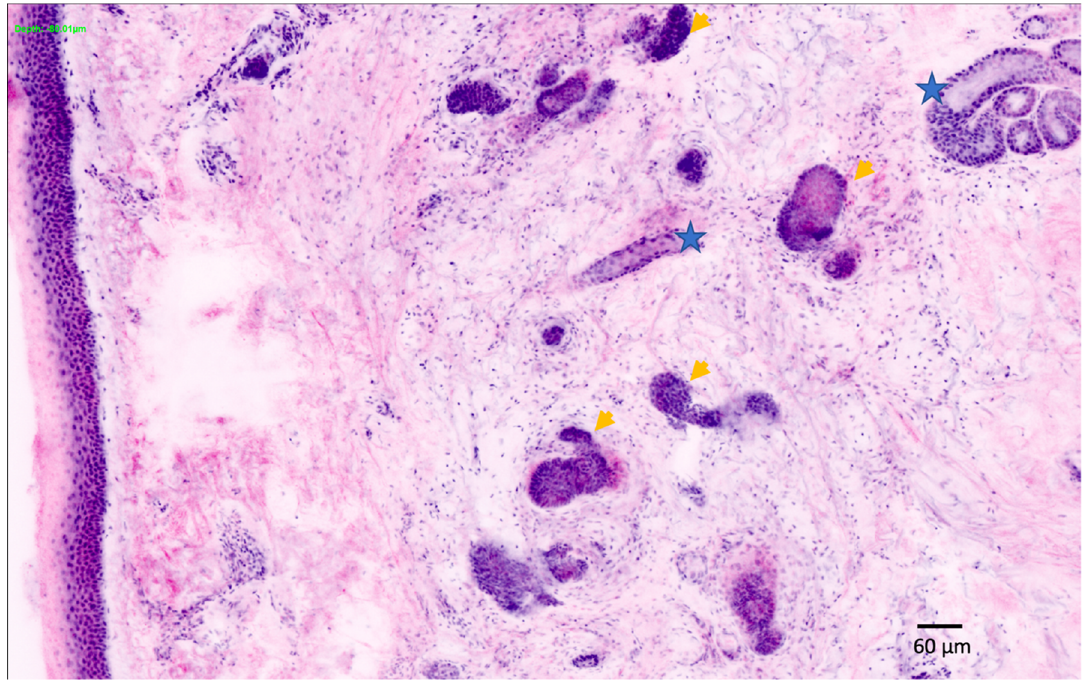
Figure 10. Ex vivo confocal microscopy of infiltrating peri glandular basal cell carcinoma. Image captured with VIVASCOPE 2500 ® : Yellow arrow: Tumor islands; Blue star: Eccrine glands.